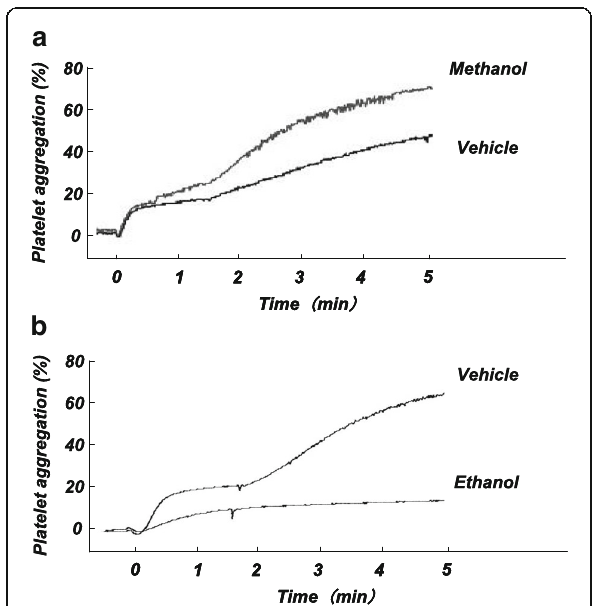
Fig. 6 Representative recordings of thrombin-induced platelet aggregation in the presence or absence of methanol ( a ) or ethanol ( b ). The effect of ethanol on platelet aggregation was examined by the same method as that used in the present study. Methanol (2%), ethanol (2%), or a vehicle was added to a platelet suspension in the nominally Ca 2+ -free solution. Platelets were stimulated with thrombin (0.025 U/ml), and platelet aggregation was induced by extracellular addition of CaCl 2 (0.5 mM) at time 0 and was measured by the light transmission method as mentioned in the “ Methods ”